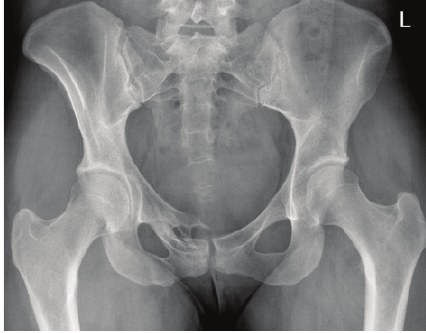
Figure 1: Anteroposterior radiographs of the pelvis demonstrating the right superior pubic fracture 5 years after the RTA.